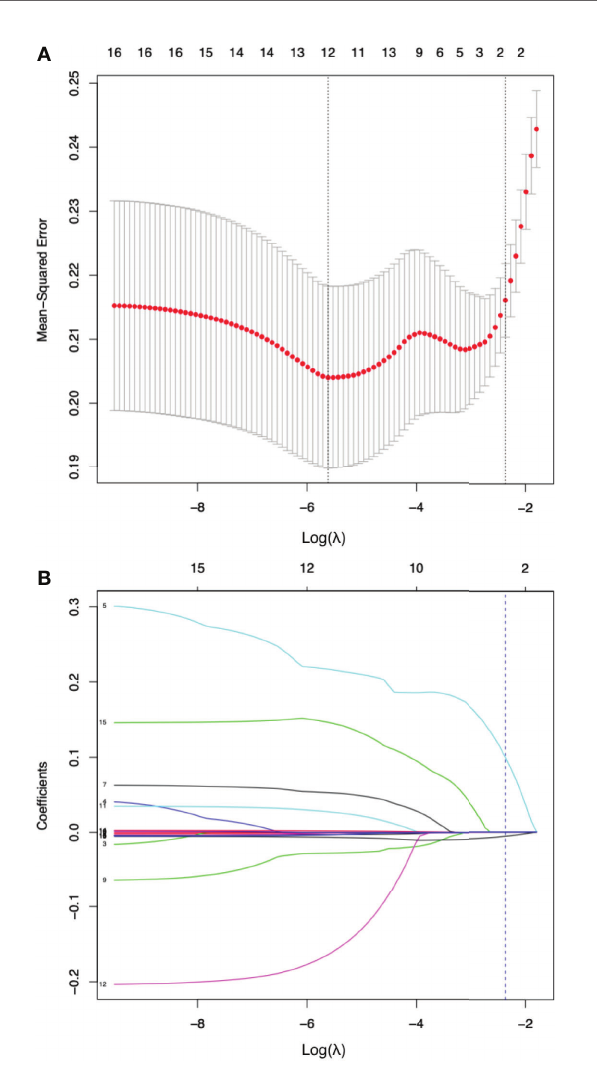
FIGURE 3 | Diagnostic variable selection by the least absolute shrinkage and selection operator (LASSO) method. (A) .Tuning parameter lambda ( l ) selection in the LASSO model with 10-fold cross validation and one-standard-error rule (the highest l for which the mean-squared error was within one standard deviation of the minimum was chose as the optimal l ). The mean-squared error was plotted versus log( l ). Dotted vertical lines were drawn at the log ( l ) with minimum mean-squared error (left one) or the optimal log( l ) by one-standard- error rule (right one). A l value of 0.094 with log ( l ) being -2.360 was chosen as optimal. (B) coef fi cient of the 16 clinical or laboratory parameters plotted against log( l ) sequence. Each curve corresponds to a variable; the dotted vertical blue line indicates the optimal value of log( l ) by one-standard-error rule at which two variables, the peripheral lymphocyte count and f/t PSA ratio had nonzero coef fi cients and the most diagnostic